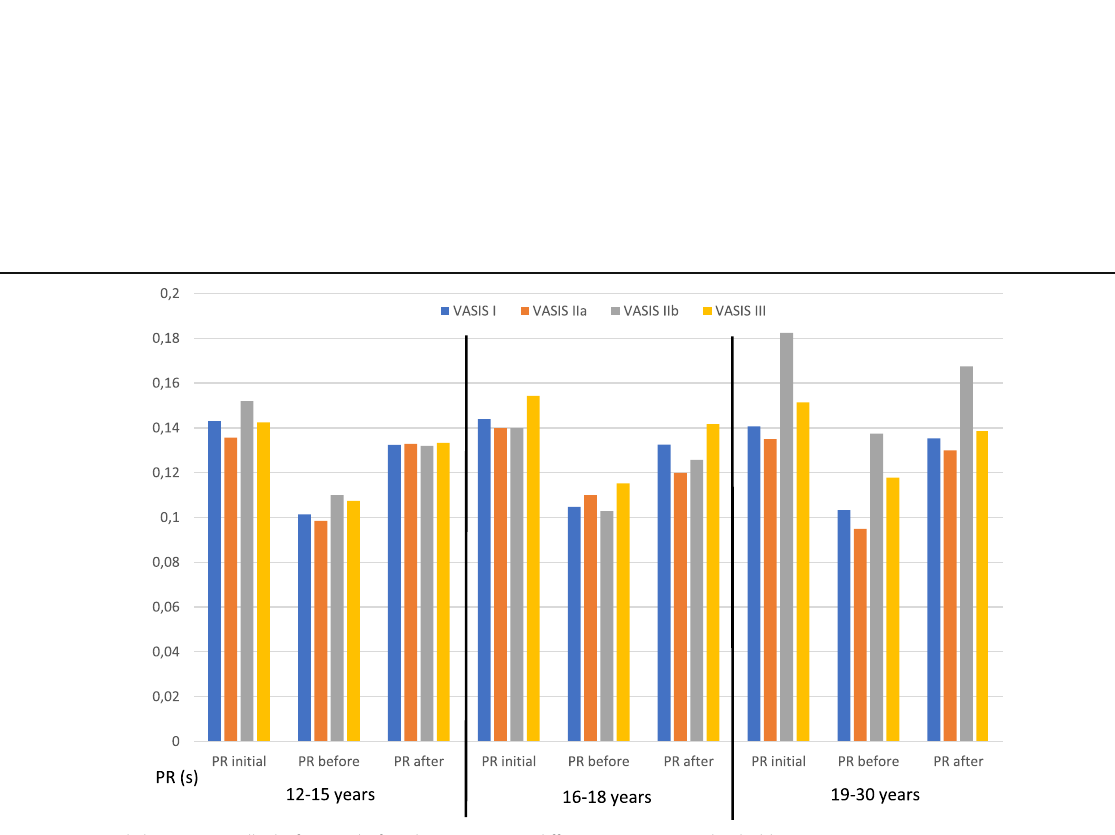
Fig. 4 PR interval duration initially, before and after the syncope in different age groups divided by VASIS